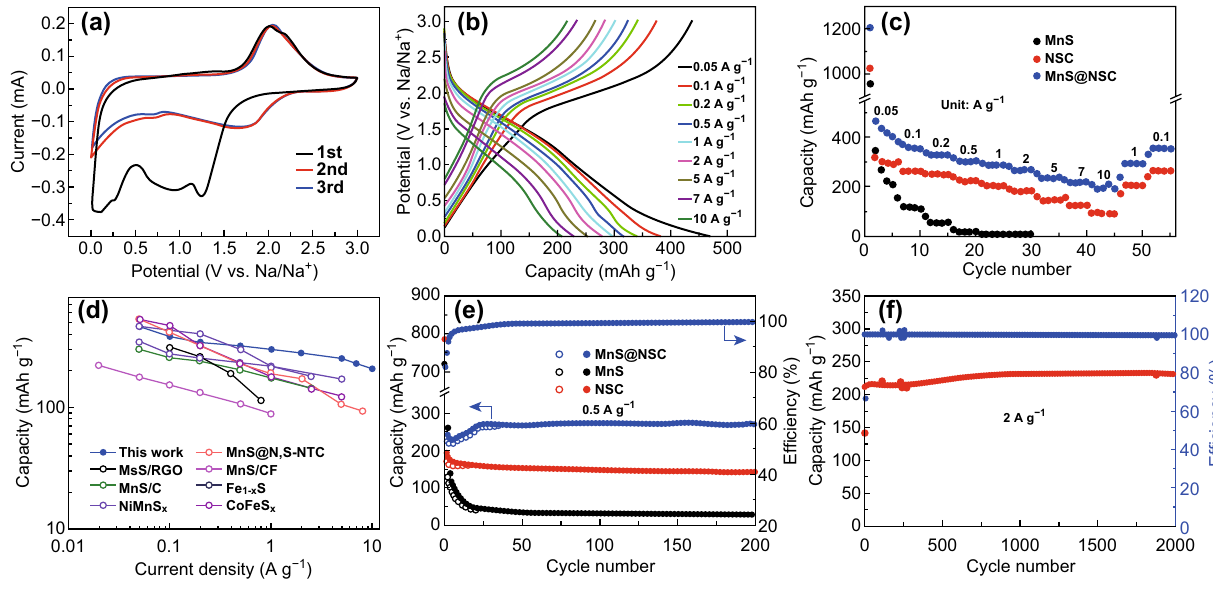
Fig. 3 a First three cycles of MnS@NSC electrode at the scan rate of 0.2 mV s −1 . b Charge/discharge curves of MnS@NSC electrode at dif- ferent current densities. c Rate performance of NSC, MnS, and MnS@NSC. d Electrochemical performance of MnS@NSC comparison with literature reported metal sulfides. e Cycling performance of NSC, MnS, and MnS@NSC electrodes at current density of 0.5 A g −1 . f Long-term cycling stability test of MnS@NSC at current of 2 A g